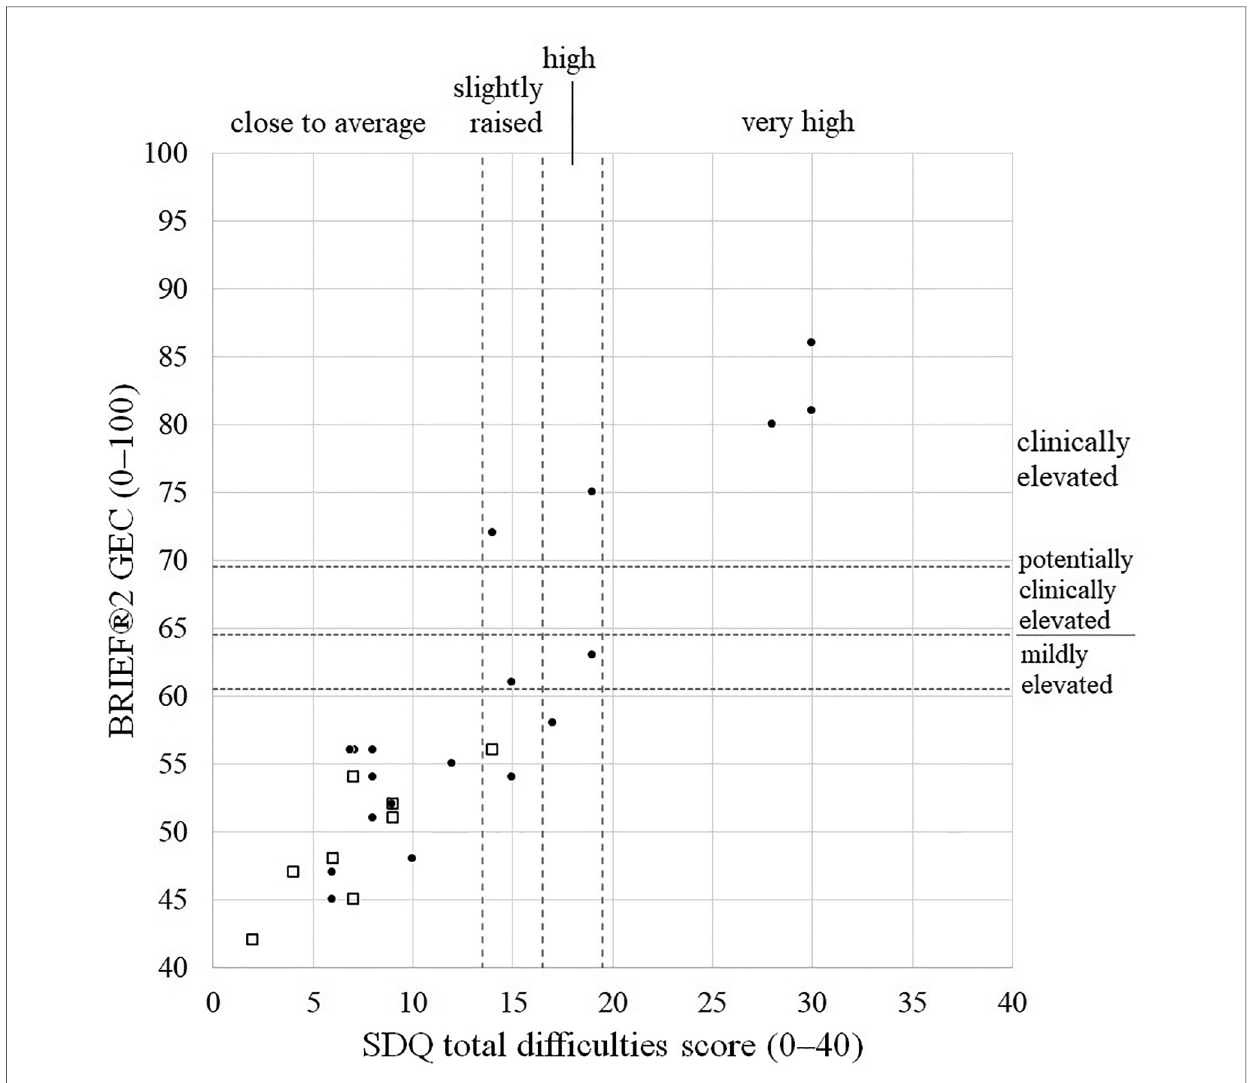
FIGURE 2 Scatterplot of BRIEF ® 2 GEC scores vs. SDQ total dif fi culties scores illustrating degree of concordance. Closed circles, exposed children; Open squares, comparison children. BRIEF ® 2, Behaviour Rating Inventory of Executive Function, 2nd edition; GEC, global executive composite; SDQ, Strength and Dif fi culties